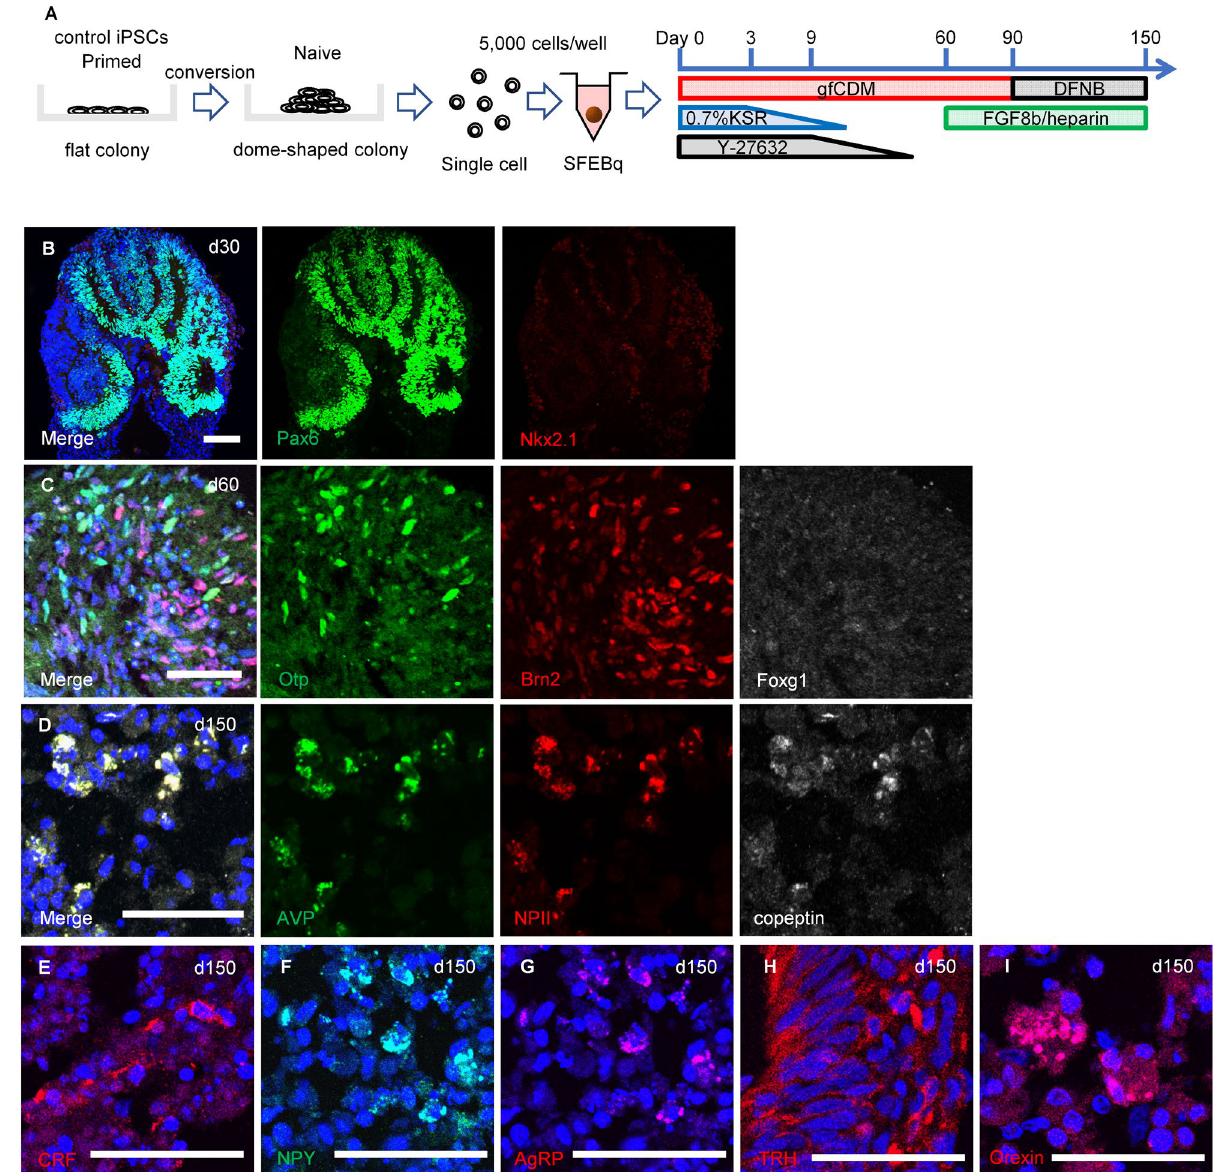
Figure 3. The partial conversion to the naive state enabled hiPSCs to differentiate into AVP neurons and hypothalamic organoid. ( A ) Scheme of the culture protocol. SFEBq using 201B7 cells recapitulated embryogenesis; on day 30, dorsal hypothalamic progenitor cells [PAX6+ (green), NKX2.1− (red)] ( B ), and on day 60, AVP precursor cells [OTP+ (green), BRN2+ (red)] ( C ), were sequentially identified. FOXG1 (white). ( D ) On day 150, differentiation into AVP neurons was achieved, with co-expression of pro-AVP components: AVP (green), NPII (red), and copeptin (white). Day 150 aggregates also expressed other hypothalamic markers such as CRF ( E ), NPY ( F ), AgRP ( G ), TRH ( H ), and Orexin ( I ). It is demonstrated that these cells are not only AVP neurons but also hypothalamic organoids. For all relevant panels, nuclear counterstaining was performed with DAPI (blue). Scale bars, ( B ) 100 µm, ( C–I ) 50